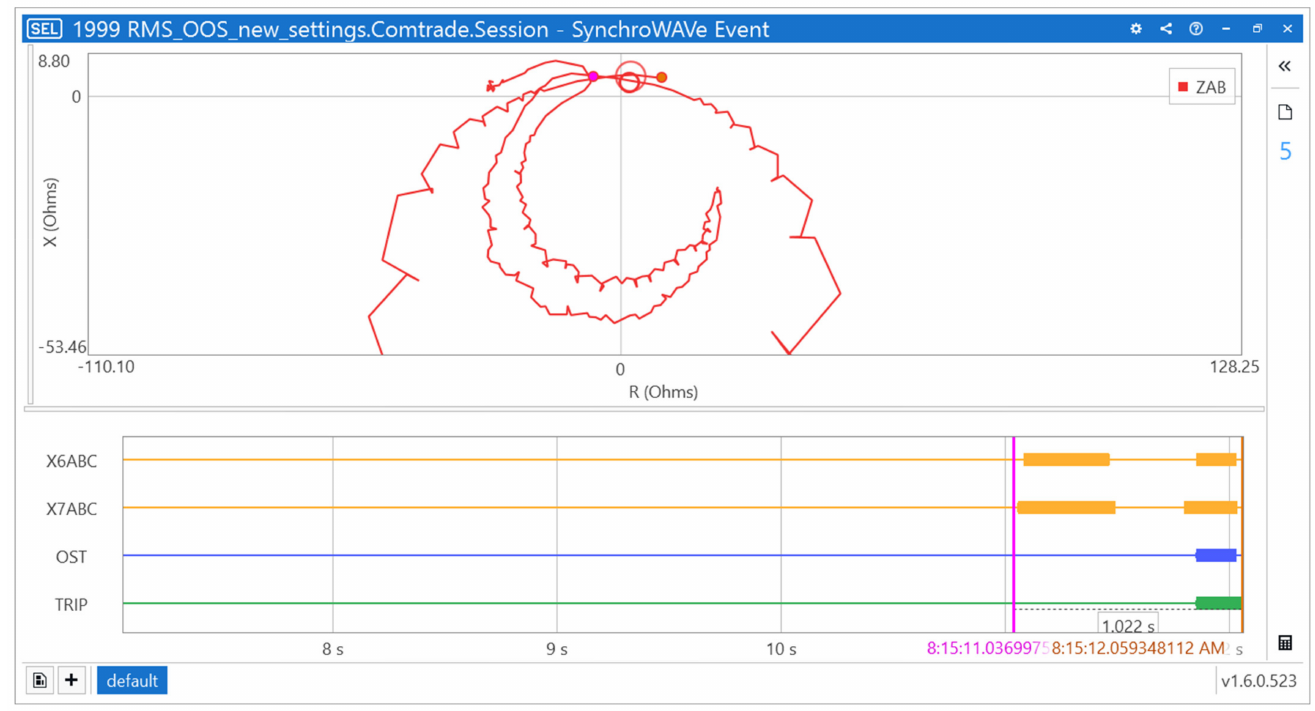
Figure 31. Trajectory of positive sequence impedance in the R-X plane and OOS logic signals for Table 203